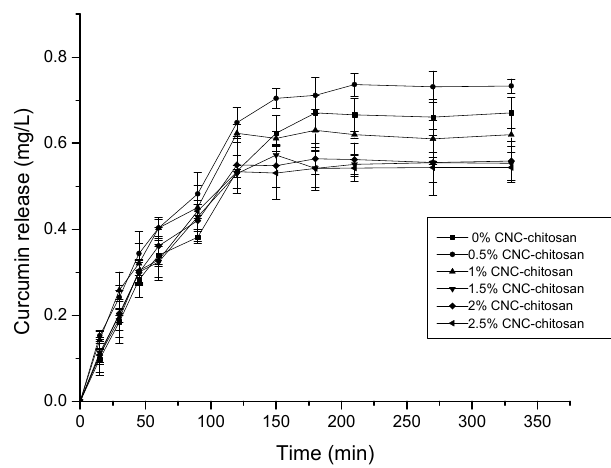
Figure 7. Curcumin release from different types of hydrogels.